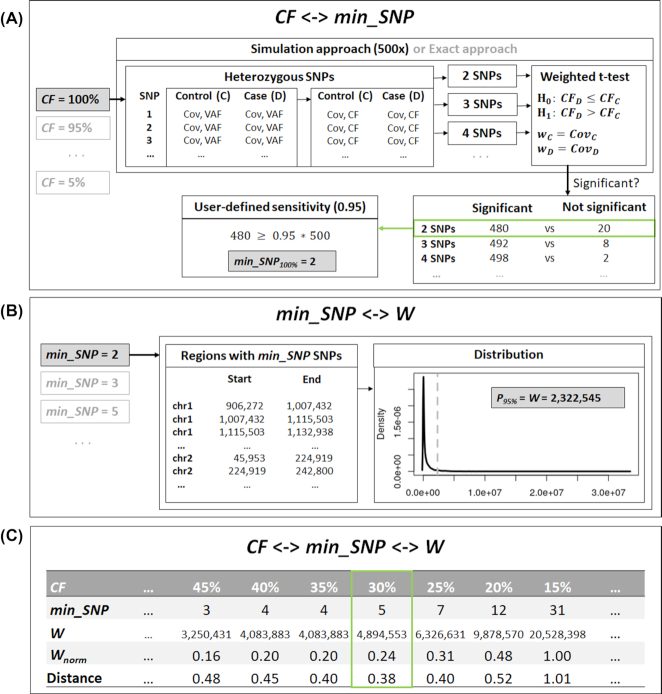
Overview of the quality analysis performed by CopyDetective. (A) A connection between CF and min_SNP is established to reach user-defined sensitivity. Following the simulation approach (default: 500×; alternative: exact approach), heterozygous SNPs are simulated. An increasing number of SNPs is evaluated, applying a weighted t-test. If a significant result is observed in ≥95% of the cases, min_SNP has been found. (B) For every relevant number of SNPs, the location of regions with min_SNP polymorphisms is determined. Based on the locations, the distribution of the region lengths is determined and \documentclass[12pt]{minimal}
\usepackage{amsmath}
\usepackage{wasysym}
\usepackage{amsfonts}
\usepackage{amssymb}
\usepackage{amsbsy}
\usepackage{upgreek}
\usepackage{mathrsfs}
\setlength{\oddsidemargin}{-69pt}
\begin{document}
}{}$P_{95\%}$\end{document}, i.e., W is calculated. (C) A connection between CF and W has been established. The optimal detection thresholds (by default: optimal trade-off between low CF and small window W) are determined. CF: cell fraction; min_SNP: minimum number of SNPs; Cov: coverage; VAF: variant allele frequency; \documentclass[12pt]{minimal}
\usepackage{amsmath}
\usepackage{wasysym}
\usepackage{amsfonts}
\usepackage{amssymb}
\usepackage{amsbsy}
\usepackage{upgreek}
\usepackage{mathrsfs}
\setlength{\oddsidemargin}{-69pt}
\begin{document}
}{}$P_{95\%}$\end{document}: 95% percentile; W: window size; Wnorm: normalized window size.